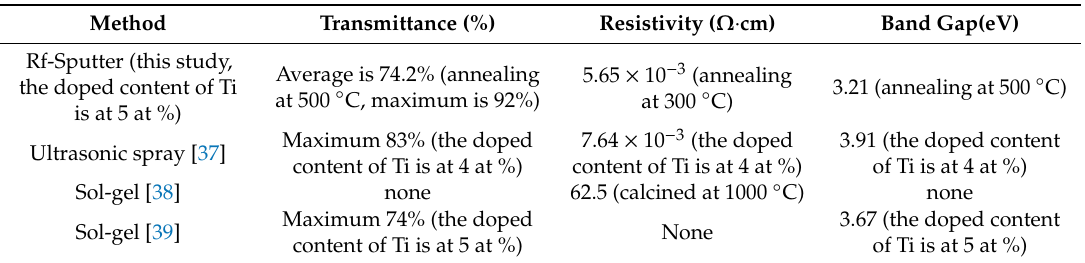
Table 5. A comparison of the values of film properties in this study with other